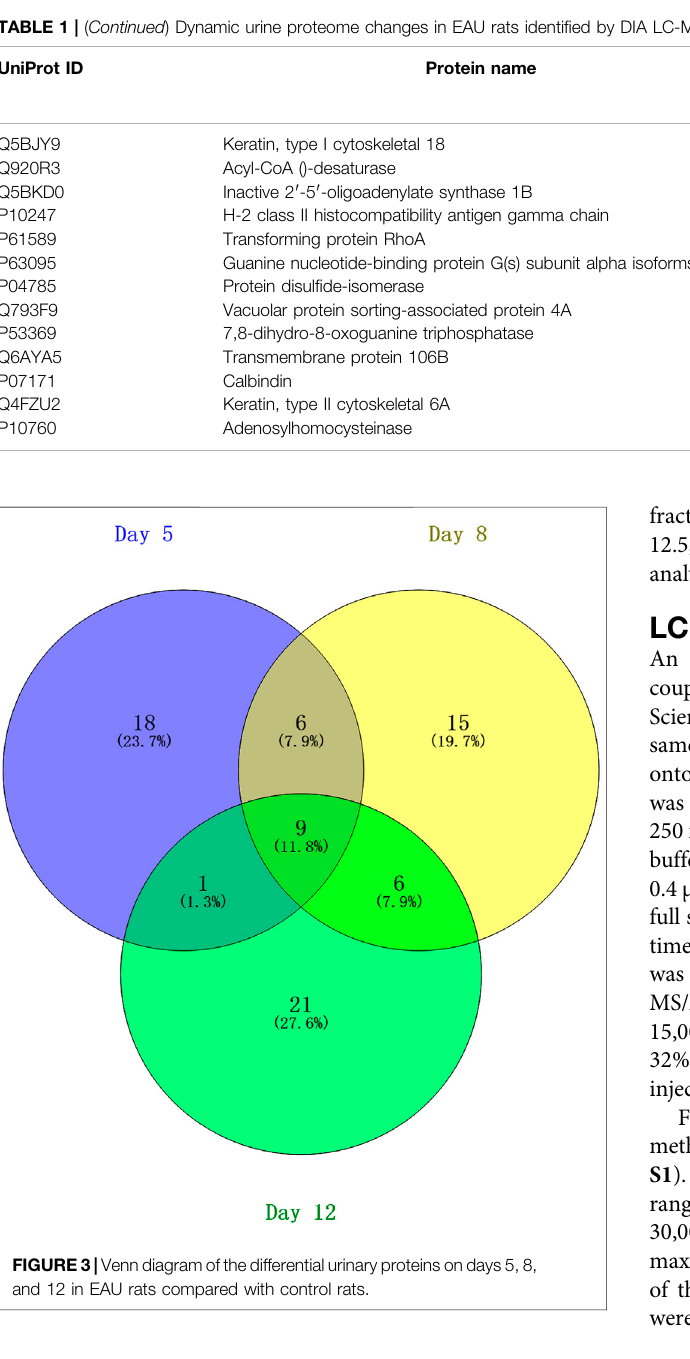
Frontiers in Molecular Biosciences |